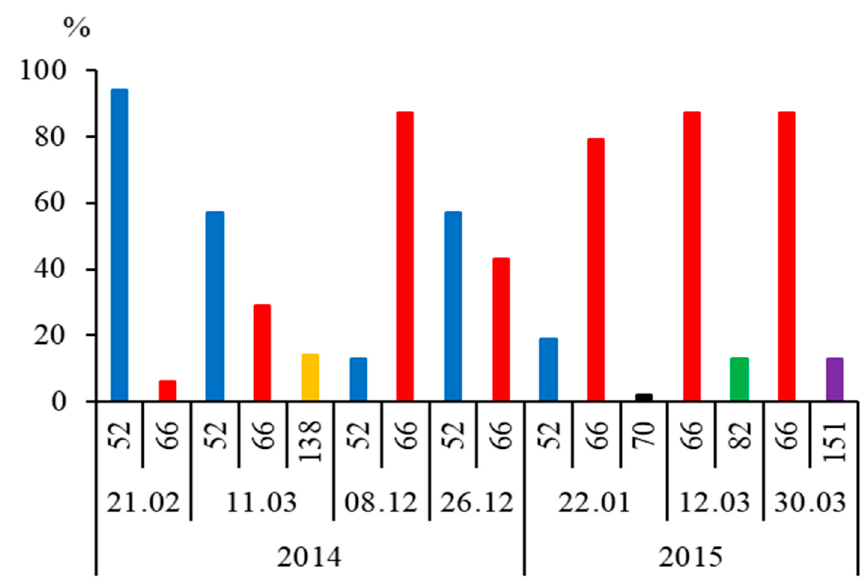
Figure 3. Relative content of PCB congeners in solid precipitations in the territory of Talgar city.